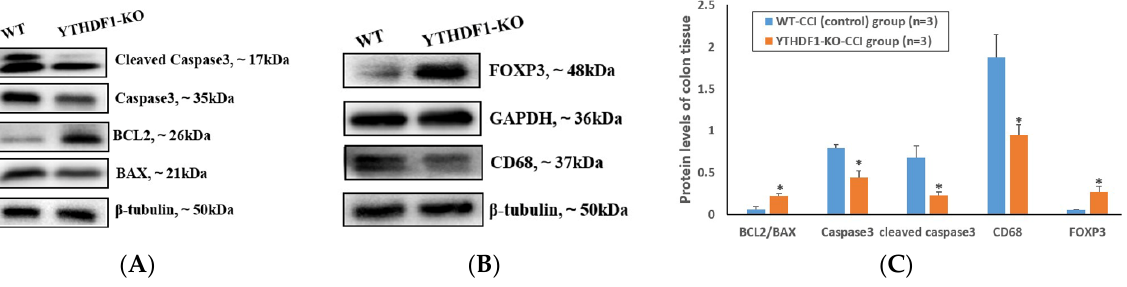
Figure 4. Western blots showed that YTHDF1 knockout significantly affected the apoptosis and inflammation protein levels in colon tissues at 3 days post-CCI. (BCL2, BAX, Caspase3, Cleaved caspase3, and CD68 were normalized to β -tubulin, while FOXP3 was normalized to GAPDH). ( A ) The pro-apoptosis protein (BAX, Caspase3, Cleaved caspase3) levels were decreased, while the anti-apoptosis protein (BCL2) level was increased in the YTHDF1-knockout group compared to the WT group. ( B ) The pro-inflammation protein (CD68) level was significantly decreased and the anti-inflammation protein (FOXP3) level notably increased in the YTHDF1-knockout group compared to the WT group. ( C ) Grayscale analyses of WB bands of BCL2/BAX, Caspase3, Cleaved caspase3, FOXP3, and CD68 were quantified. Values are means ± SEs. * p < 0.05.